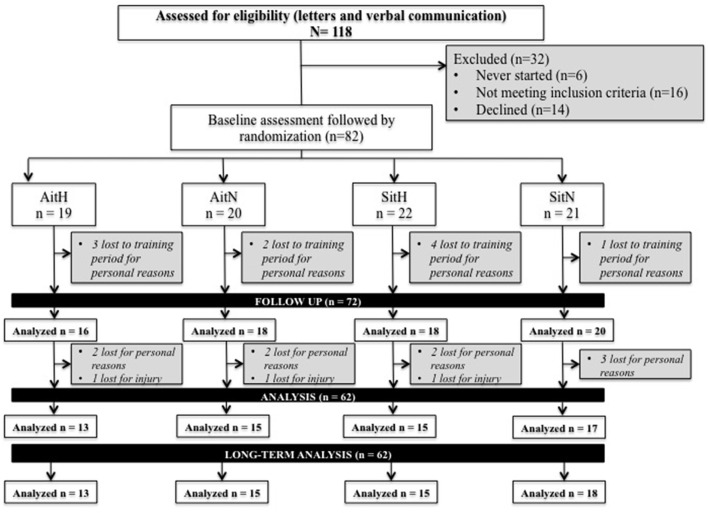
Flow of participants through each stage of the trial. AitH: Aerobic interval training Hypoxia group; AitN: Aerobic interval training Normoxia group; SitH: Sprint interval training Hypoxia group; SitN: Sprint interval training Normoxia group.